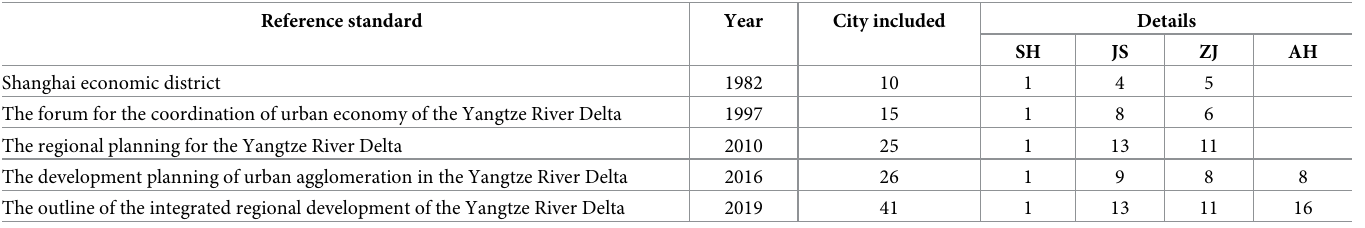
Table 5. Planning documents in the Yangtze River